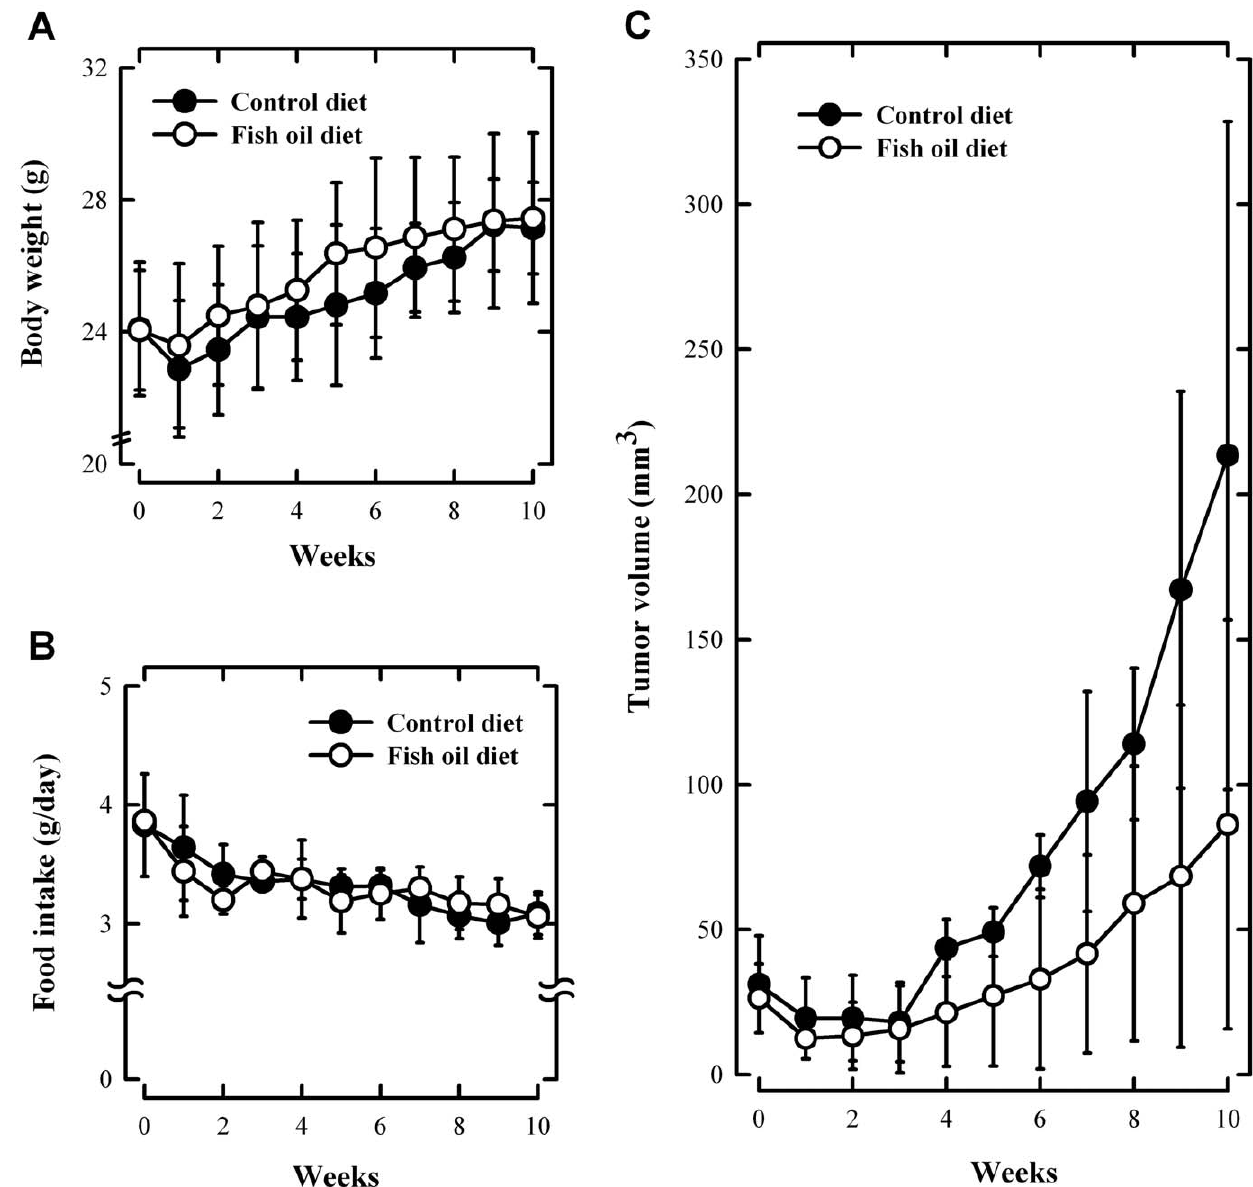
Figure 5. Fish oil-supplemented diet only slightly inhibits the growth of MDA-MB-435s cancer cell xenografts in athymic nude mice. The changes in body weight ( A ), food intake amount ( B ) and tumor growth ( C ). Nude mice were maintained on control or fish oil diet for 6 weeks after subcutaneous implantation of MDA-MB-435s cells (5 6 10 6 cells in 100 m L PBS). Both maximum and minimum diameters of the tumors, body weight and food intake amounts were measured twice a week using slide caliper. Tumor volume was calculated assuming the tumor to be spherical using the following formula: volume= p /6 6 d 3 , where d is the mean diameter. Each value is the mean 6 S.D. (n=5).